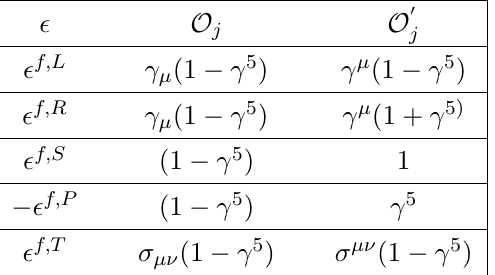
Table 1 . Effective operators and effective couplings in eq. (2.1) studied in this